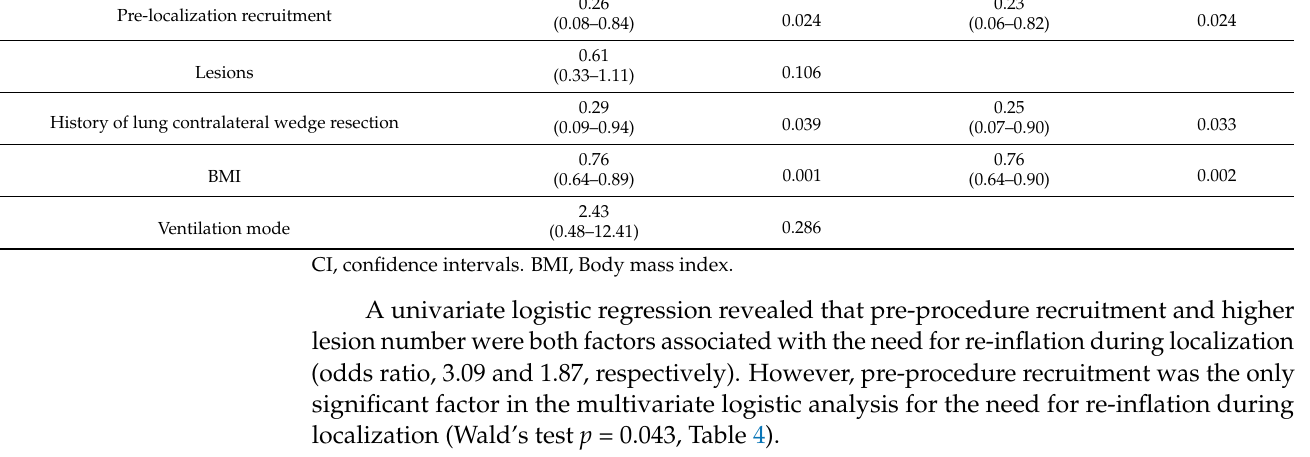
Table 4. Predictors of